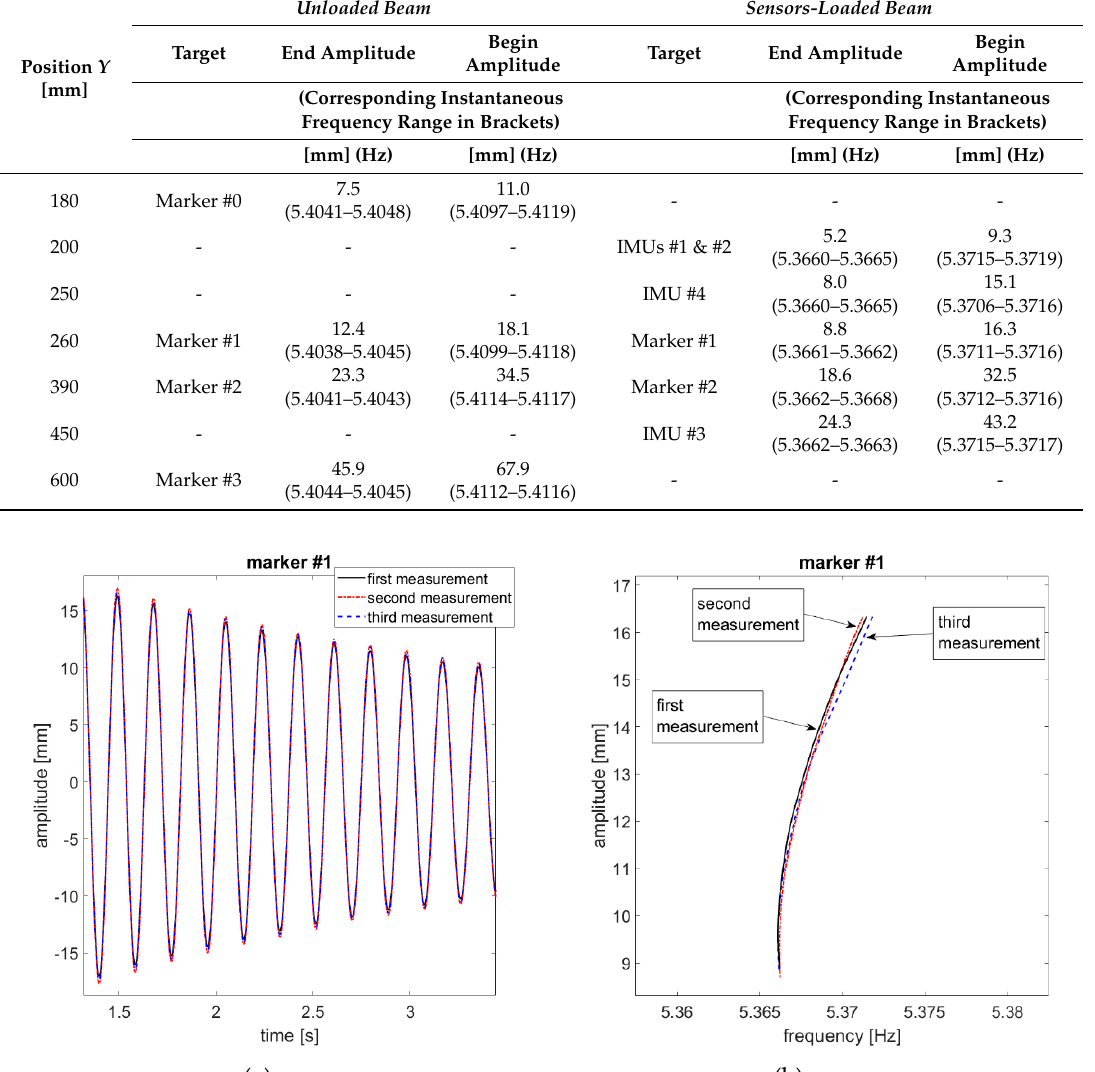
Table 6. Beginning and end amplitude for the targets in unloaded and loaded conditions.